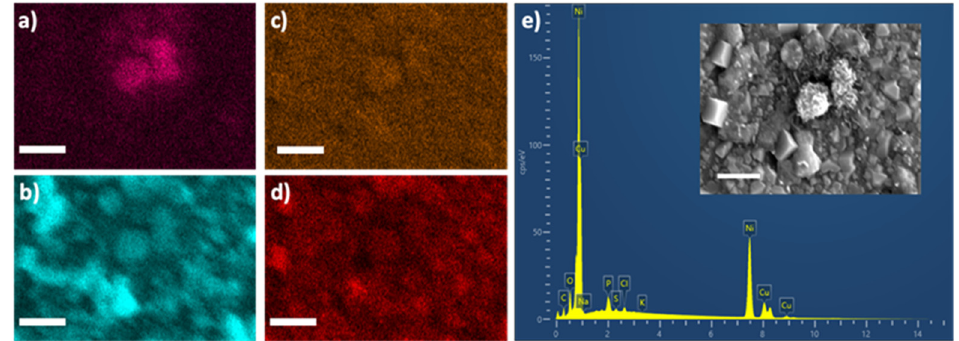
Figure 3. Morphology and elemental composition of PBS-Cu-Ni electrode. Energy-dispersive X-ray spectroscopy (EDS) maps for ( a ) chlorine (Cl), ( b ) copper (Cu), ( c ) phosphorous (P), ( d ) oxygen (O). ( e ) The corresponding EDS spectra. Inset—SEM image of the mapped region. Scale bar: 1 µm.